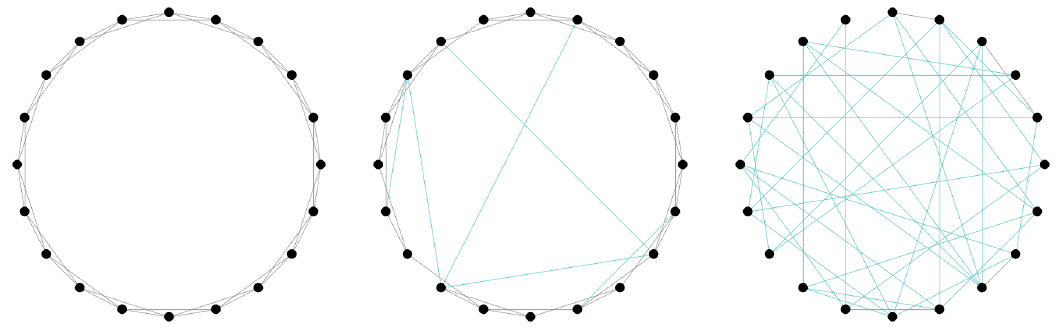
Figure 10. Rewiring in the Watts–Strogatz model [75]. ( Left ) p = 0; ( Middle ) p = 0.2; and ( Right ) p =